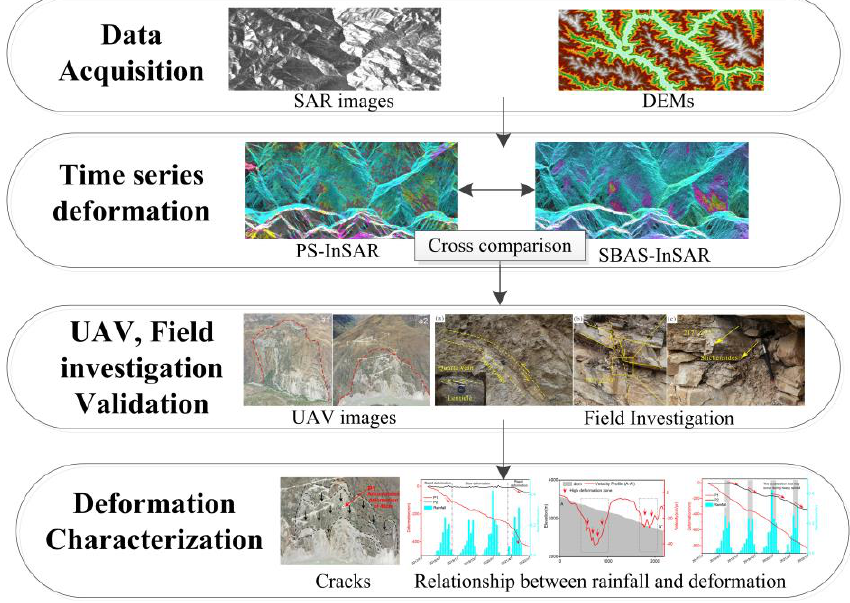
Figure 3. Workflow chart of this study.